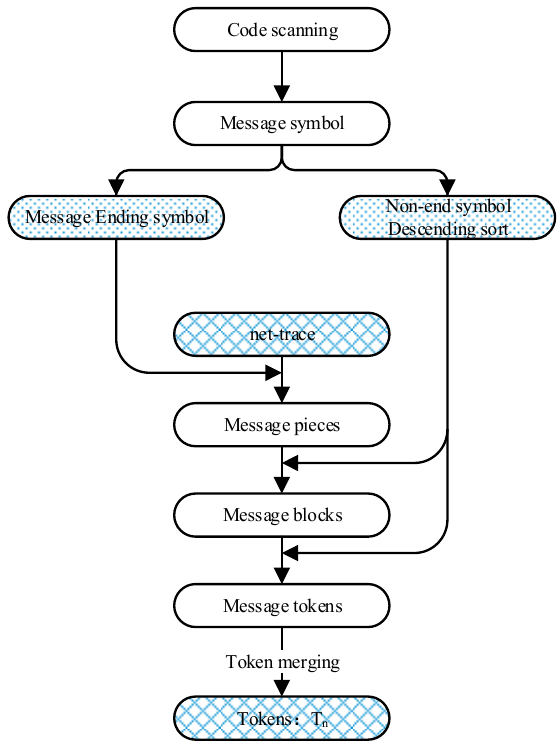
Figure 14. Net-trace parse module.